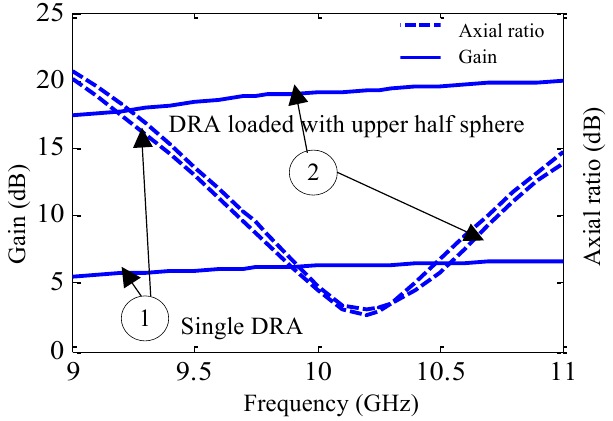
Figure 12: The gain and the axial ratio versus frequency for DRA loaded with upper half dielectric sphere compared to a single DRA.